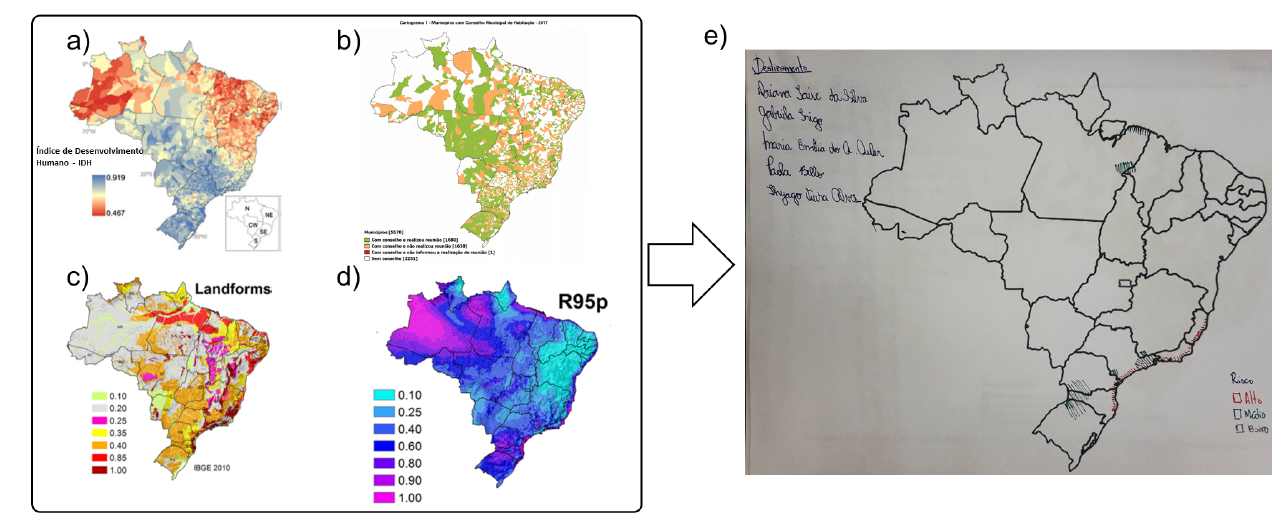
Figure A12. Package of maps used in the third training for mapping climate risk associated with landslides. The maps illustrate (a) Human Development Index (HDI; Torres et al., 2012), (b) municipalities with council for housing (IBGE, 2017), (c) landforms (Debortoli et al., 2017), (d) annual total precipitation when rainfall > 95th percentile (R95p; Debortoli et al., 2017), and (e) the climate risk map drawn by the